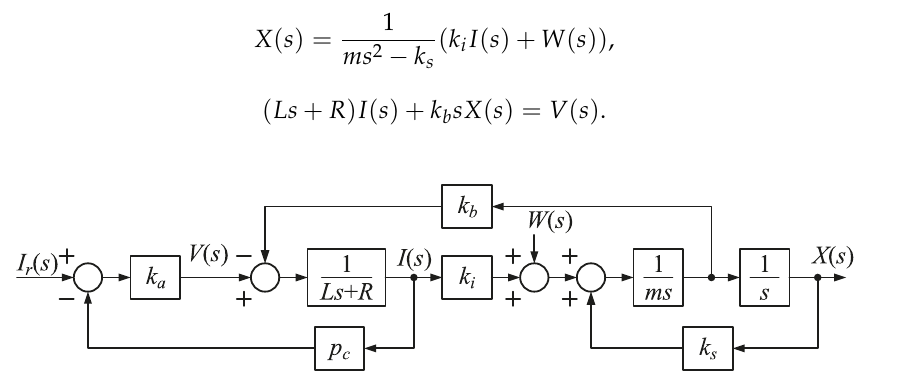
Figure 7. Block diagram of the magnetic suspension apparatus with the amplifier.